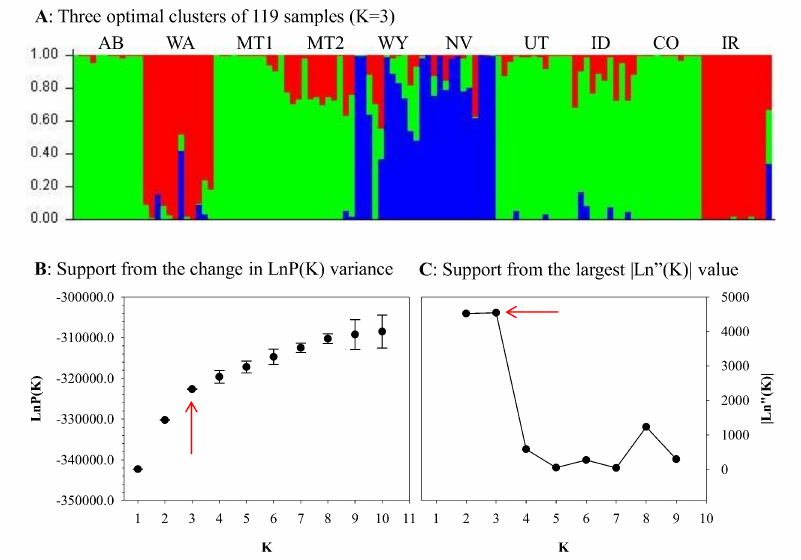
Figure 2. Three genetic clusters of the 119 northern wheatgrass samples inferred by the STRUCTURE analysis based on the 5659 SNP markers. ( A ) The mixture coefficients of 119 samples with K = 3, presented in the original order of samples from the 10 accessions (see Table 1 for accession label; the first four accessions from the left are for cultivated accessions and the rest are for wild accessions). ( B ) Support from the LnP(K) estimation, highlighted by the red arrow. ( C ) Support from the estimation of the largest absolute value of the second-order rate of change of the likelihood distribution |Ln”(K)|, highlighted by the red